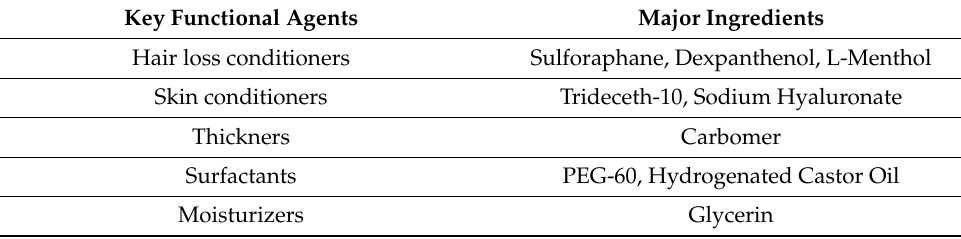
Table 1. Summary of formula ingredients that were proposed for the clinical application test. Key Functional Agents